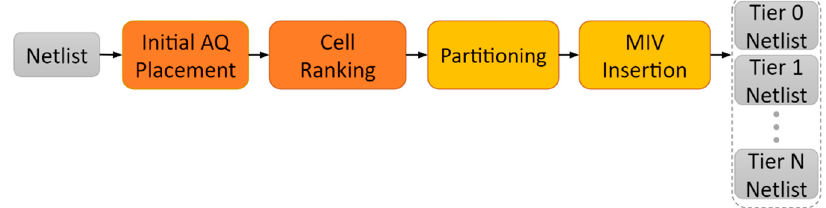
Figure 5. AQ partitioning